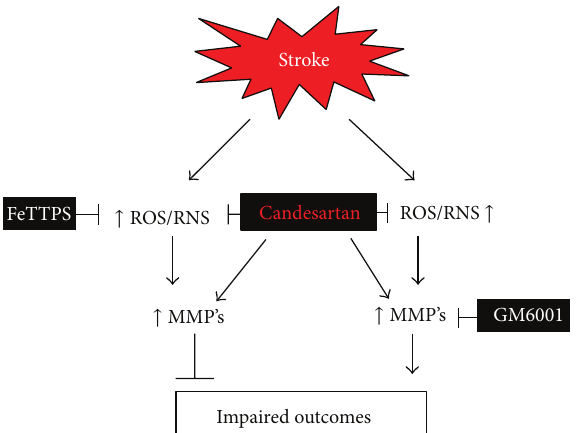
Figure 5: Schematic of experimental hypothesis for the possi- ble mechanisms of candesartan-induced acute protection. ROS: reactive oxygen species, RNS: reactive nitrogen species, MMP: matrix metalloproteinases, FeTPPs: a peroxynitrite decomposition catalyst, 5,10,15,20-tetrakis (4-sulfonatophenyl)porphyrin to iron III chloride, and GM6001: a broad spectrum MMP